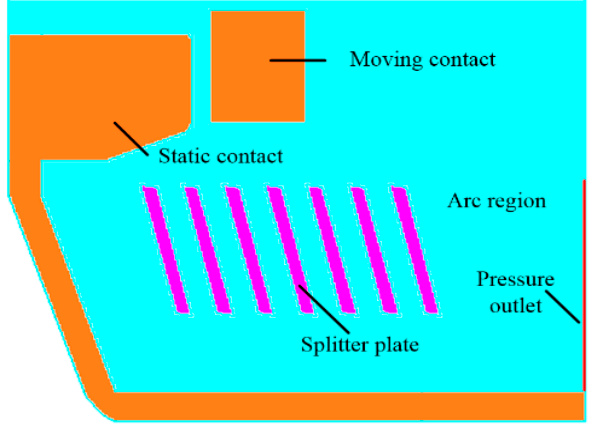
Figure 2. Simulation model.